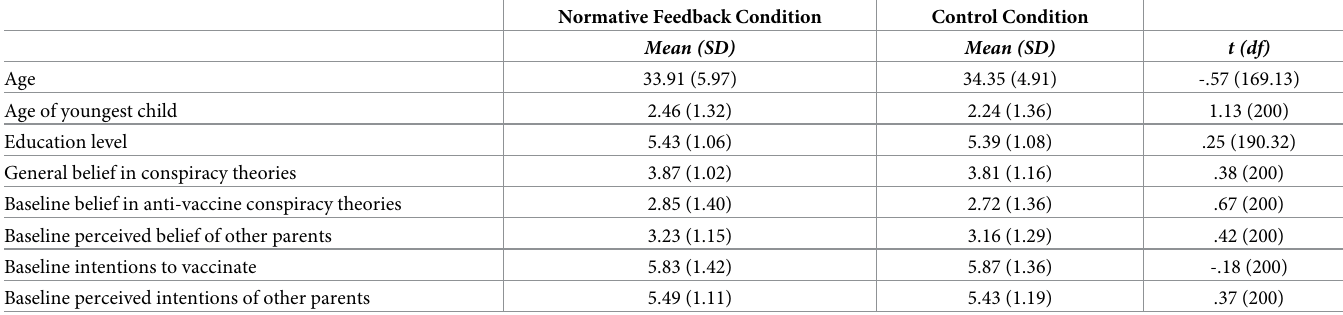
Table 1. Means, standard deviations and equivalence tests between the normative feedback and control conditions of baseline